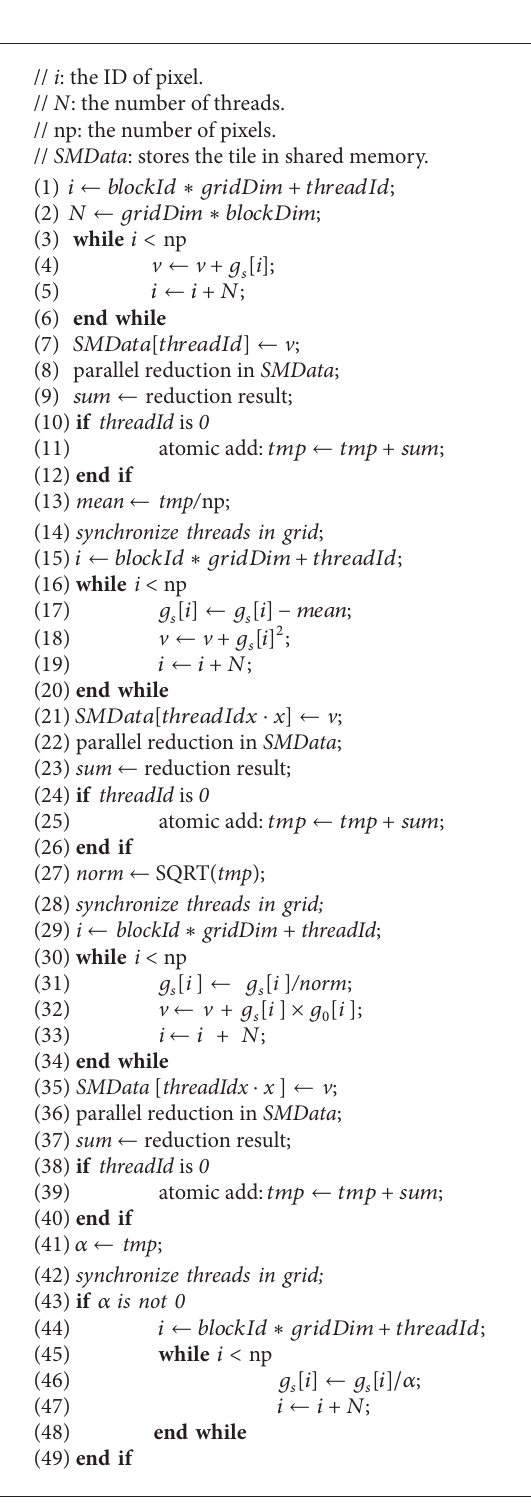
Algorithm 5: GPU-based method for normalizing 𝑔 𝑠 .